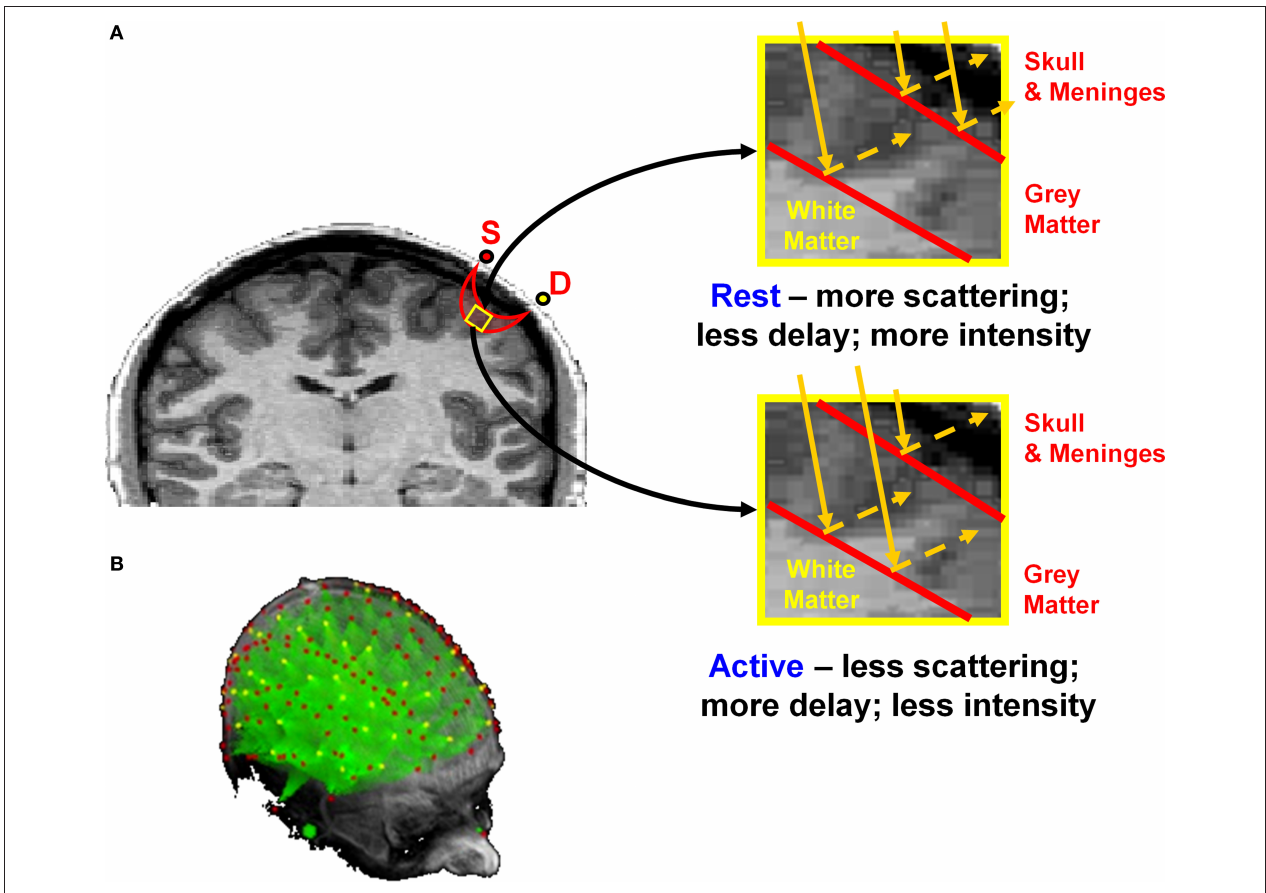
Figure 1 | (A) Schematic representation of the back-scattering of photons under conditions of rest and activity in the cortex. S = Source (red dot); D = detector (yellow dot). As shown in the right panels, changes in transparency of the cortex are associated with changes in photon penetration and path